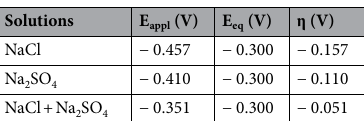
Table 5. The over potential values of copper electrode (3.14mm 2 ) at 60 °C.